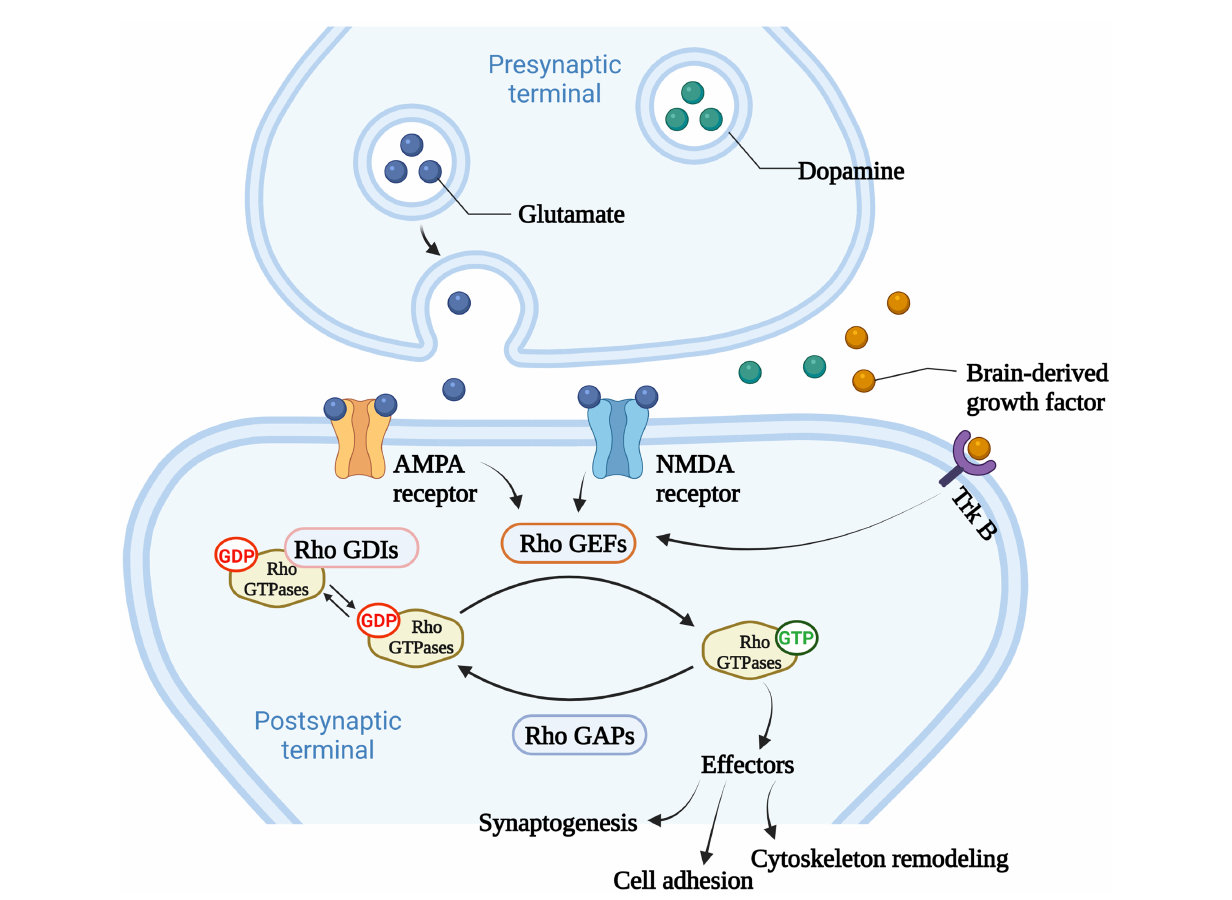
FIGURE 2 The main function of Rho GTPases. Rho GTPases cycles between an active GTP-bound state in the cell membrane and an inactive GDP-bound state in the cytoplasm, and the activity of Rho GTPases is regulated by Rho GTPases guanine nucleotide exchange factors (Rho GEFs), Rho GTPase activating proteins (Rho GAPs), and Rho GTPases guanine nucleotide dissociation inhibitors (Rho GDIs). Rho GEFs catalyze the conformational change of Rho GTPases and activate Rho GTPases. Rho GAPs facilitate the hydrolysis of GTP into GDP within Rho GTPases, and deactivate Rho GTPases. Rho GDIs inhibit the dissociation of GDP from Rho GTPases and stabilize the inactivation of Rho GTPases. Rho GTPases act as important molecular switches to transmit signals to downstream effectors that regulates numerous cellular functions, such as cytoskeleton remodeling, cell adhesion and other essential life processes.